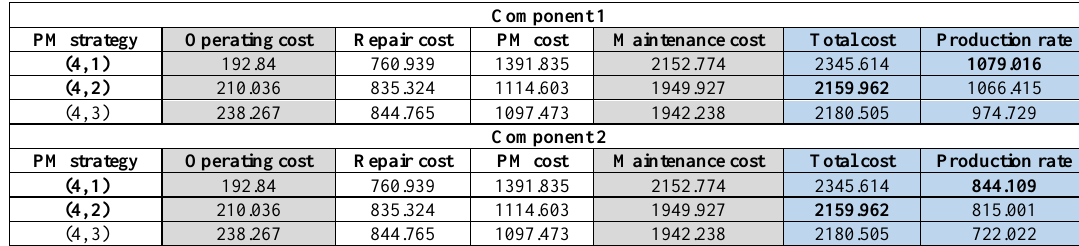
Table 7. Results for components 1 and